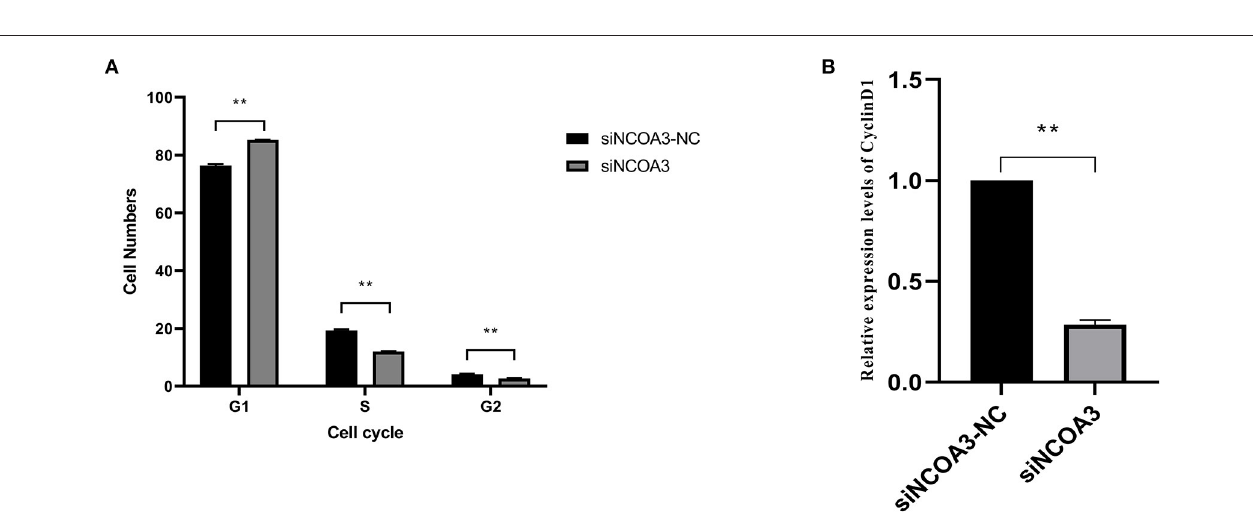
FIGURE 7 | The effects of inhibiting NCOA3 expression on cell cycle and expression level of CyclinD1 . (A) The effects on cell cycle after interfering expression of NCOA3 . (B) After 48h of interference expression of NCOA3 , cells were collected. The expression levels of CyclinD1 were detected. ** p <